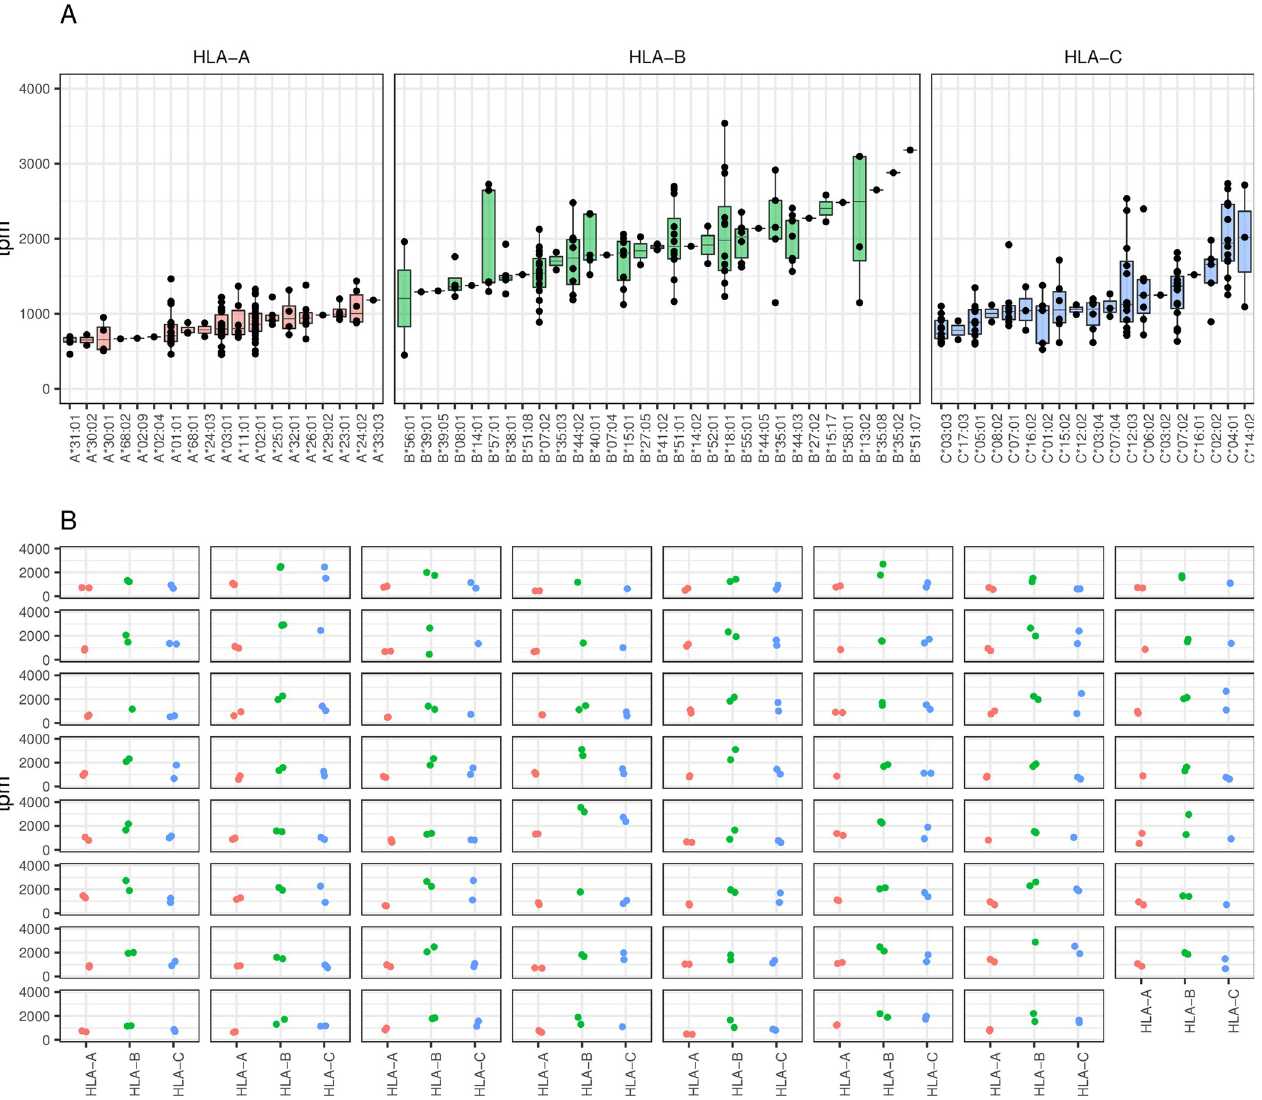
Fig 1. Gradient HLA class I expression at the allelic level. Panel (A) HLA class I RNA expression measured in samples of PBMCs obtained from 63 individuals is plotted as tpm (transcript per million) per allele (indicated on the horizontal axis) for HLA-A, B and C. Nine-teen HLA-A, 31 HLA-B and 19 HLA-C unique alleles are detected. Mean expressions are 866 ± 224, 1870 ± 541and 1238 ± 532 tpm for HLA-A, B and C, respectively. Each dot represents the expression of an allele in one individual. Note that the HLA typing inferred from RNA sequencing corresponded to the available high-resolution typing performed on DNA. Panel (B) Allelic expression is plotted per locus (horizontal axis) and per individual. Each facet represents one individual and each dot one